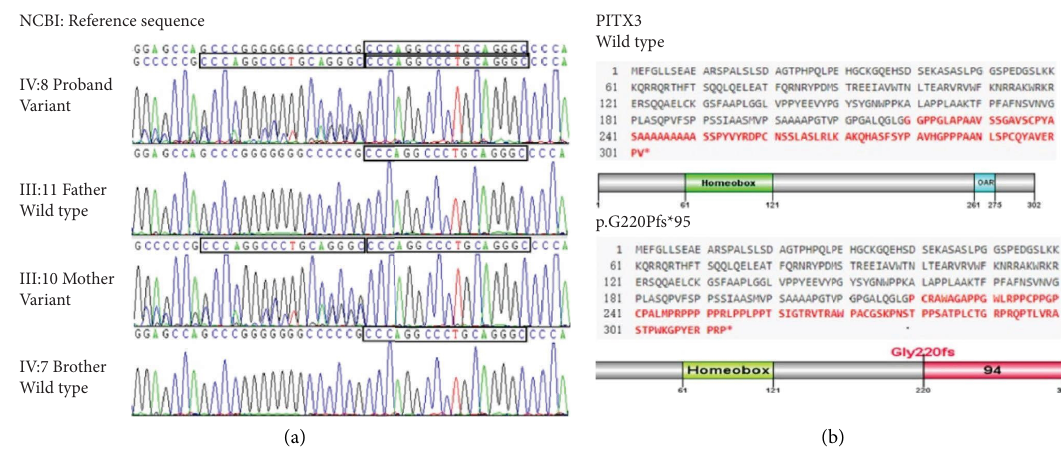
Figure 3: Sanger sequencing of PITX3 gene mutation. (a) Te PITX3 gene mutation was not detected in healthy individuals in the family (reference transcript: NM_005029), and the heterozygous mutation c.640_656dup (p.G220Pfs ∗ 95) was detected in the afected individuals, with 17bp inserted at 657bp position (as shown in the box). (b) Te duplication of 17bp fragment in the PITX3 gene